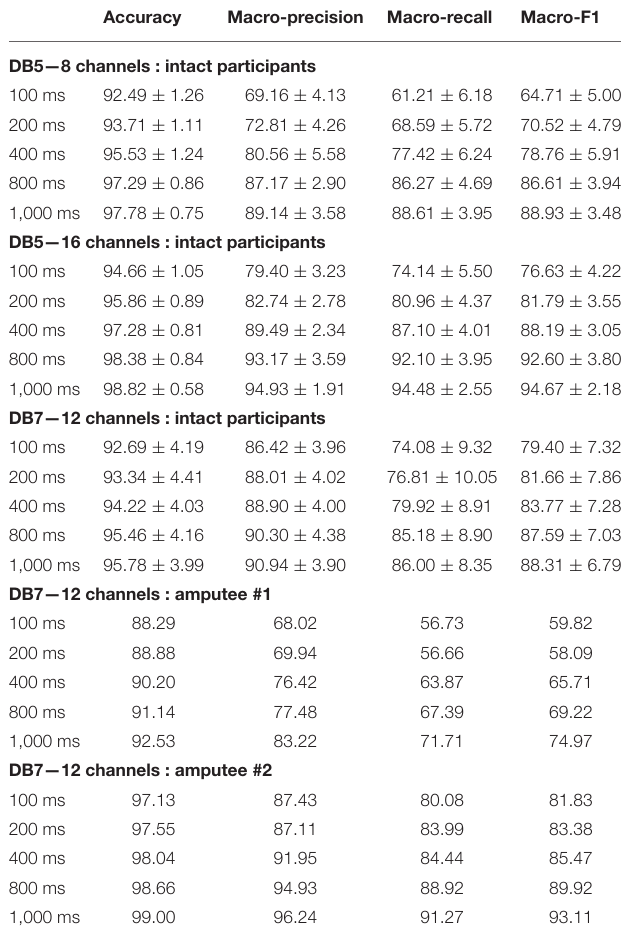
TABLE 4 | Accuracy and macro-averaged metrics of the proposed deep neural network classifiers for SHAP prehensile patterns. Accuracy Macro-precision Macro-recall